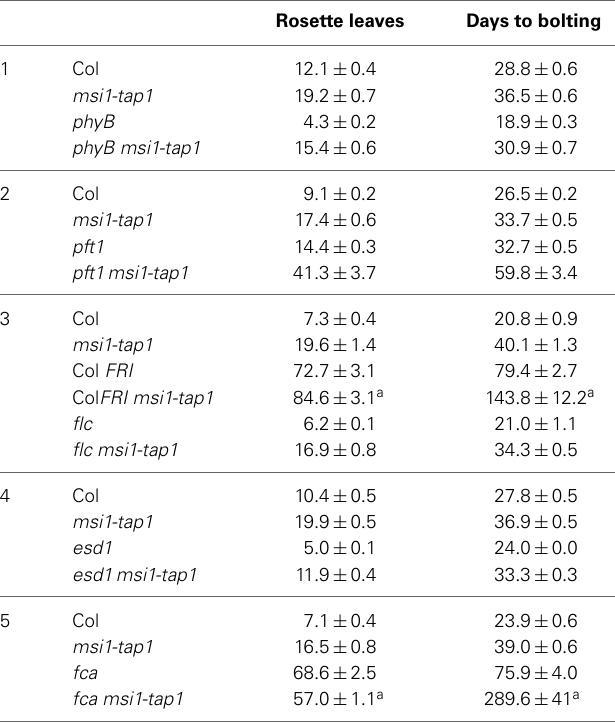
Table 1 | Flowering time of double mutants of msi1-tap1 and different flowering time mutants in